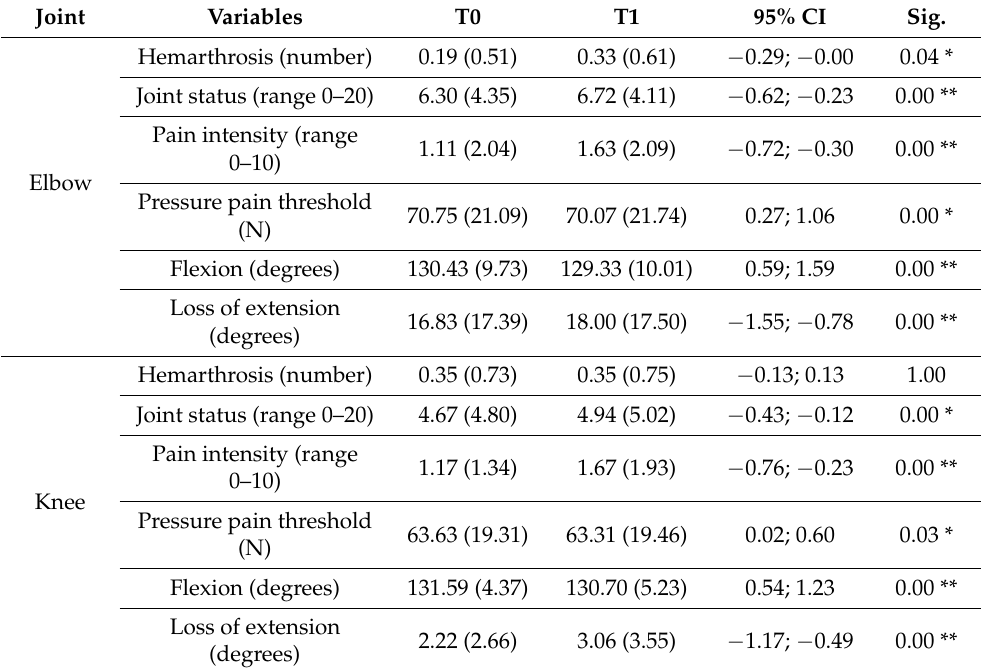
Table 2. Descriptive statistics (mean and standard deviation), confidence interval and changes in all joints after the quarantine